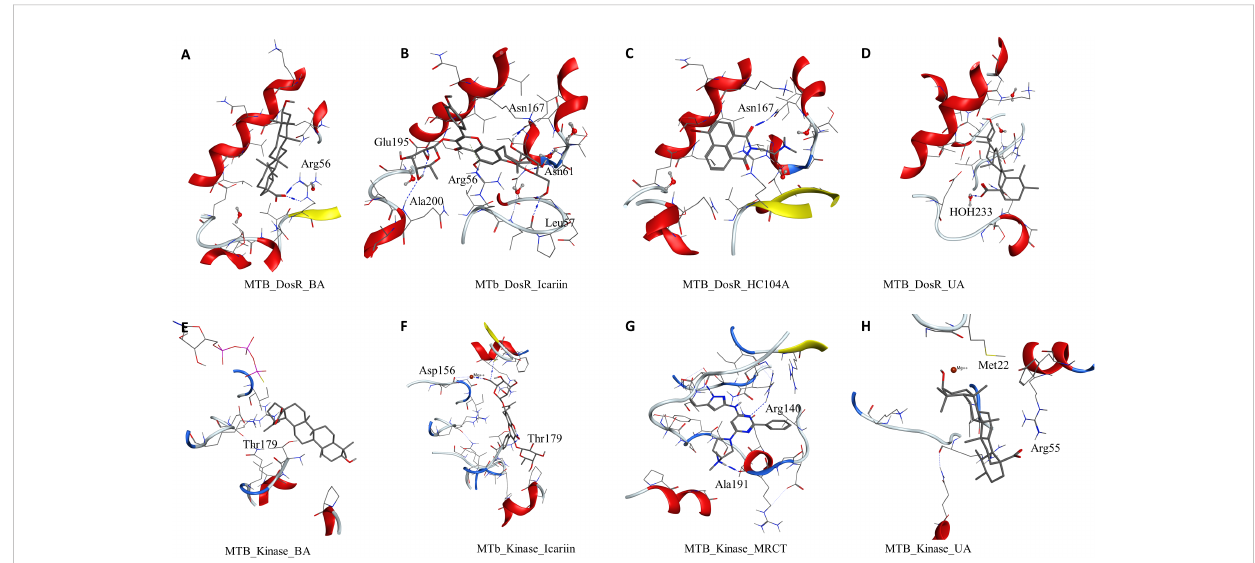
FIGURE 3 Molecular docking results for M. tuberculosis dormancy survival regulator (DosR) (PDB: 3C3W): (A) DosR – BA, (B) DosR – IC, (C) DosR – HC104A, and (D) DosR – UA. Molecular docking results for M. tuberculosis serine/threonine protein kinase (STPK) (PDB: 1MRU): (E) STPK – BA, (F) STPK – IC, (G) STPK – MRCT67127, and (H) STPK –